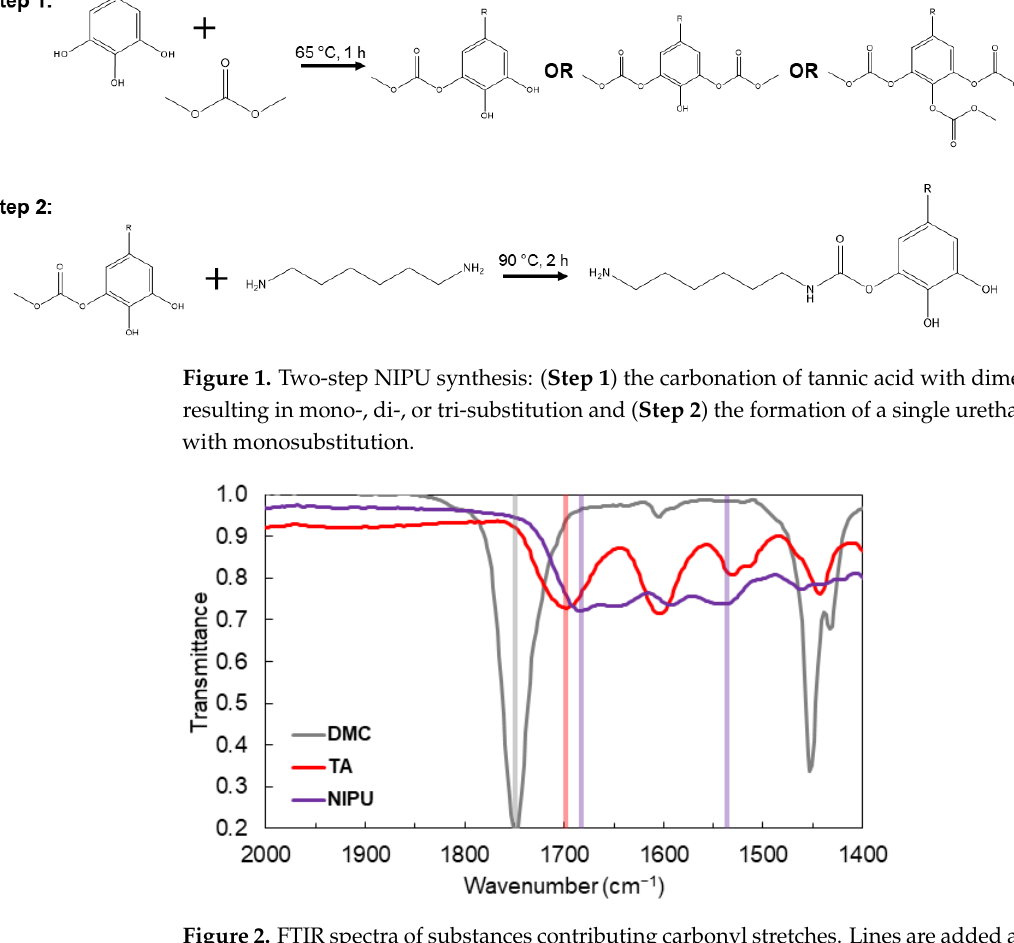
Figure 2. FTIR spectra of substances contributing carbonyl stretches. Lines are added at the maximum absorbance frequency for easier comparison. (DMC: dimethyl carbonate; TA: tannic acid; NIPU: non-isocyanate polyurethane).